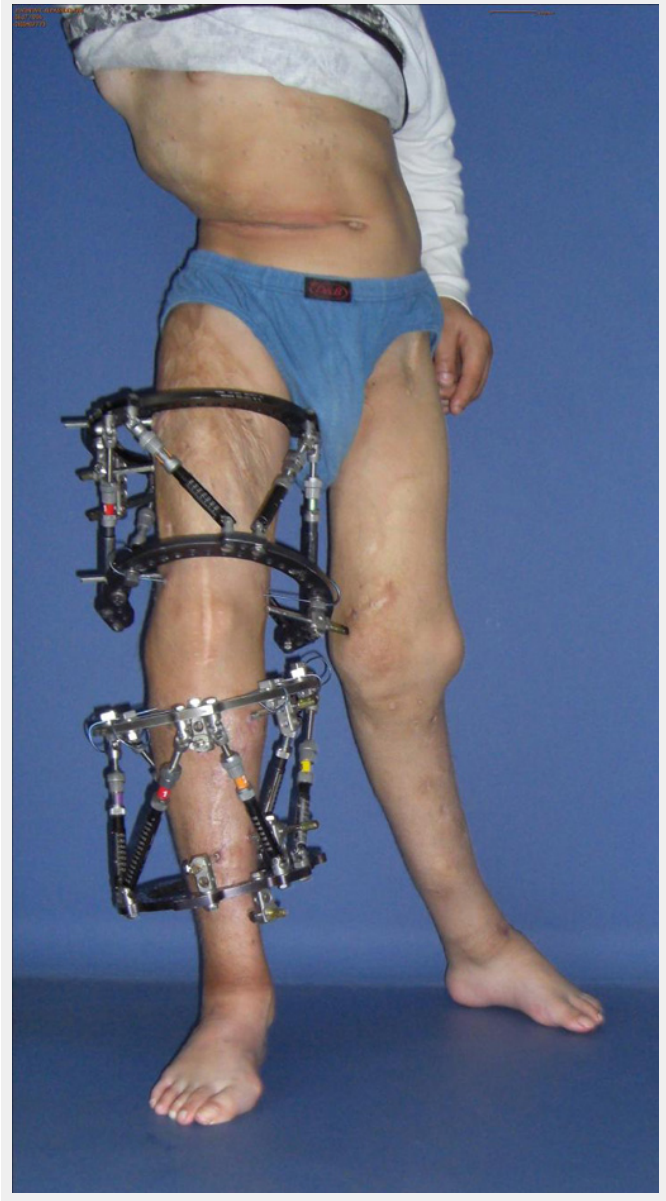
Figure 5 After distal femoral and proximal tibial osteotomy, the severe varus deformity was corrected by gradual distraction using the Taylor Spatial